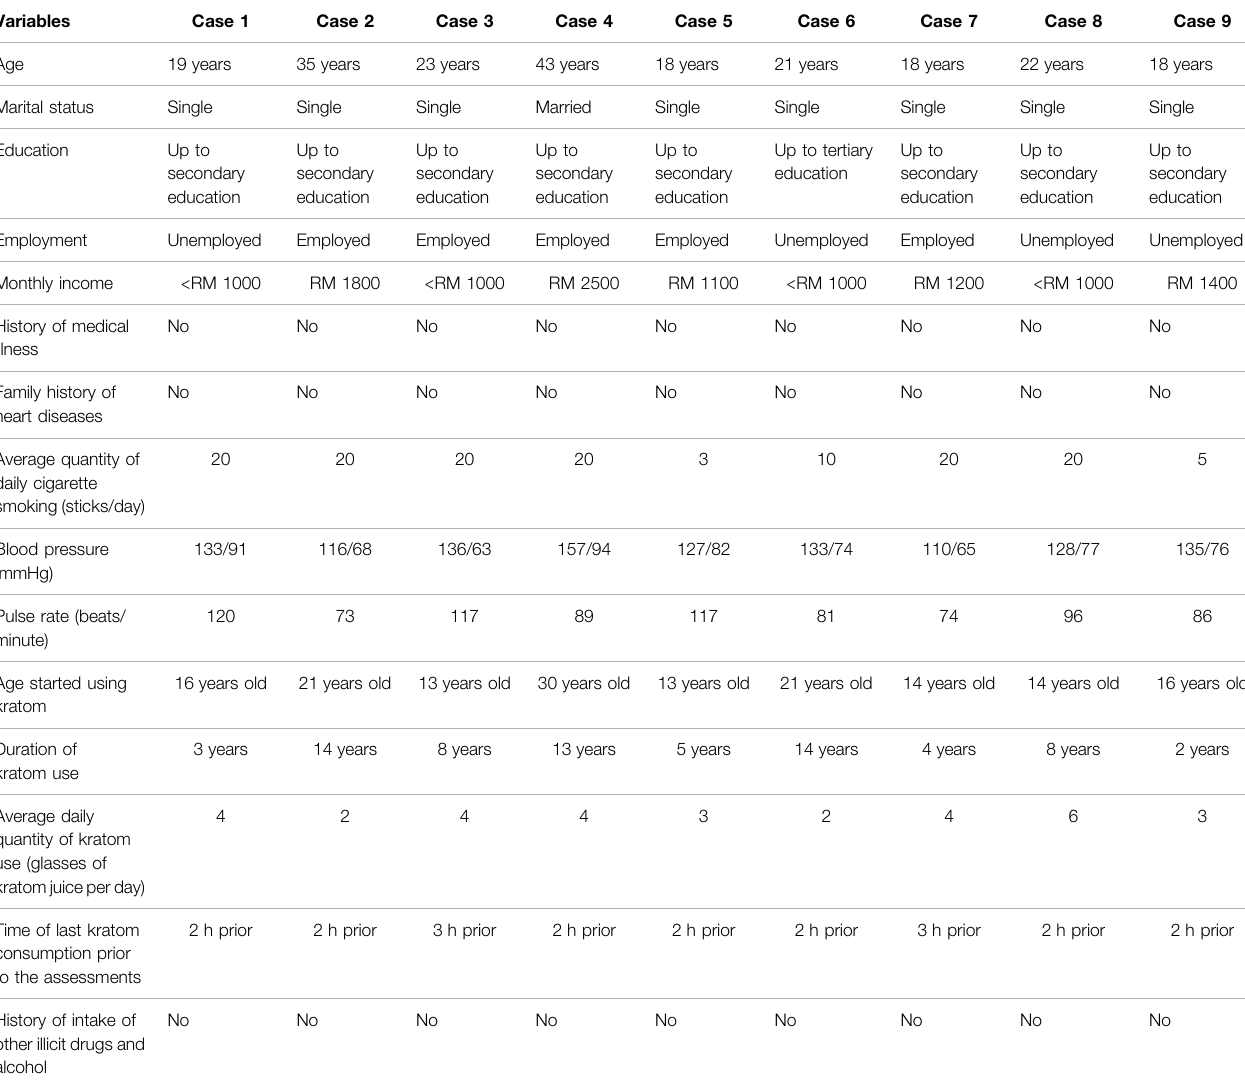
TABLE 1 | Detailed demographic and clinical data, and kratom use characteristics of the respondents.